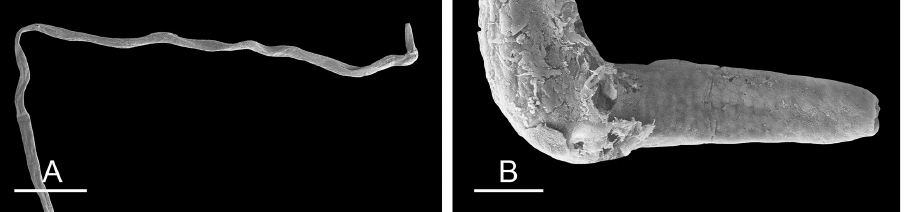
Figure 58. Penis, Wallaconchis comendadori , Philippines, Bohol [3385] (PNM 041234). A View of entire penis, scale bar 0.5 mm B Distal tip of penis, scale bar 50 μm.